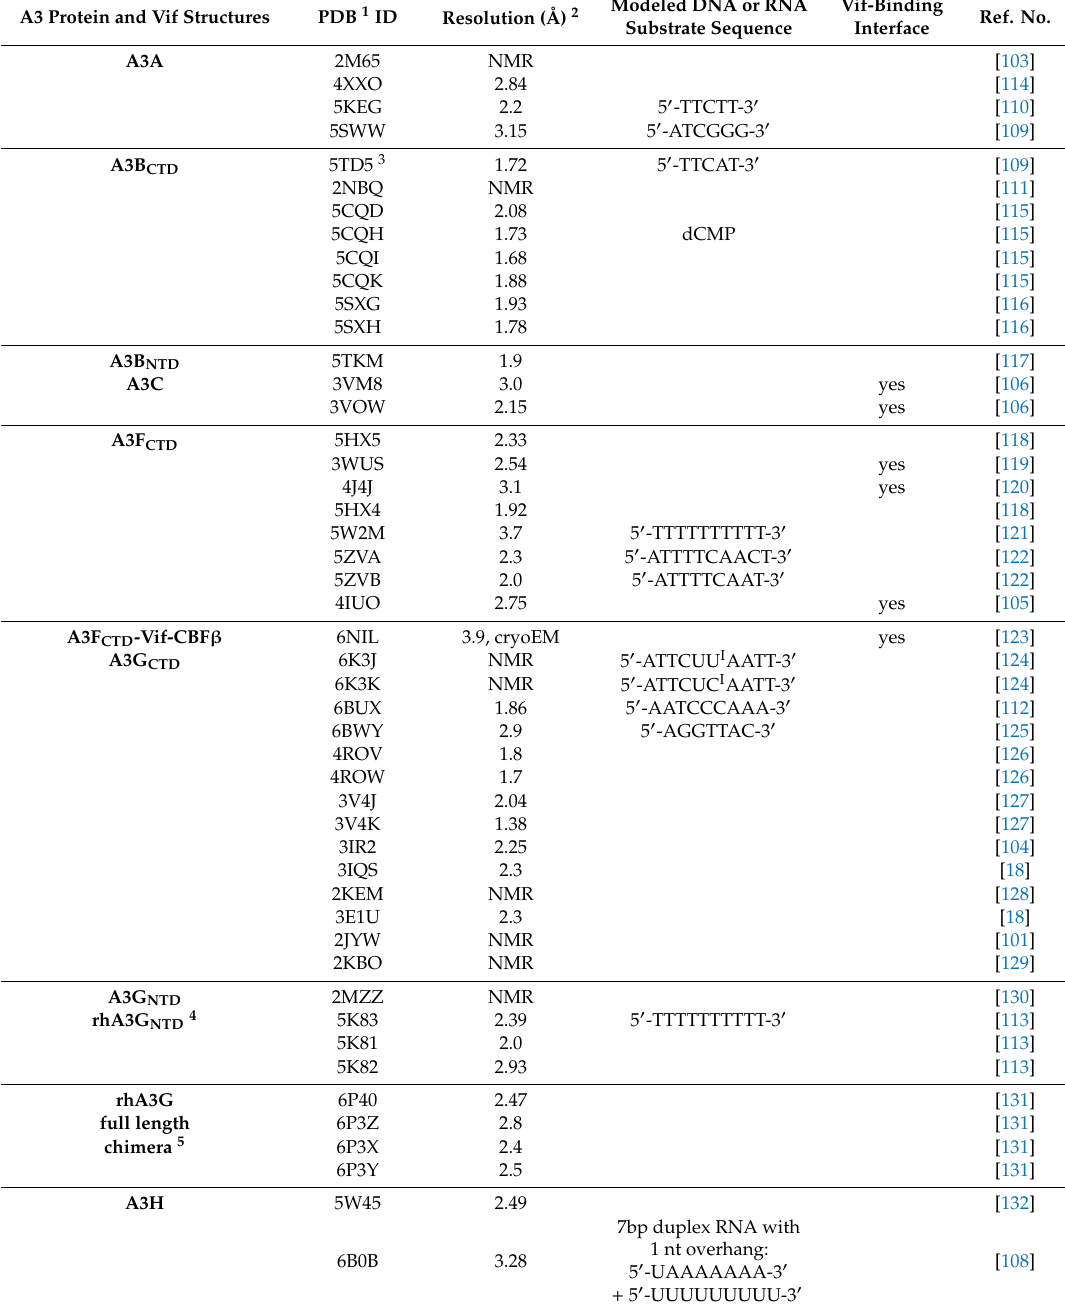
Table 1. Structures of Vif and A3